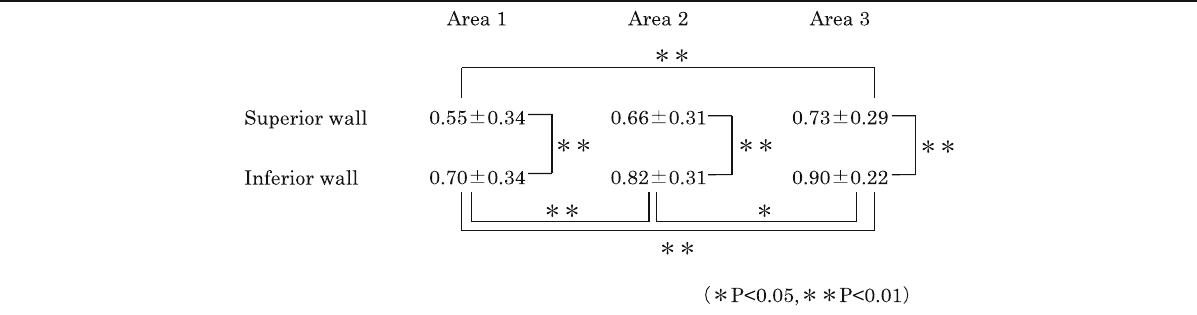
Table 2 Mean visibility ratio ± SD